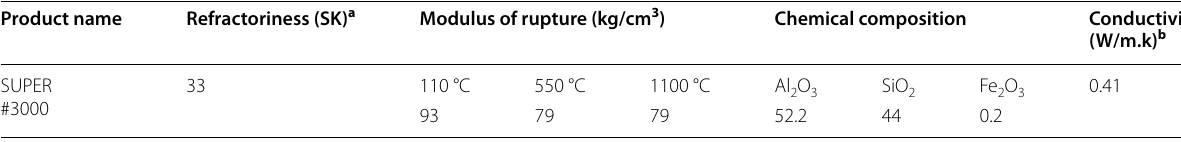
Table 3 Material properties of mortar for fire protection.